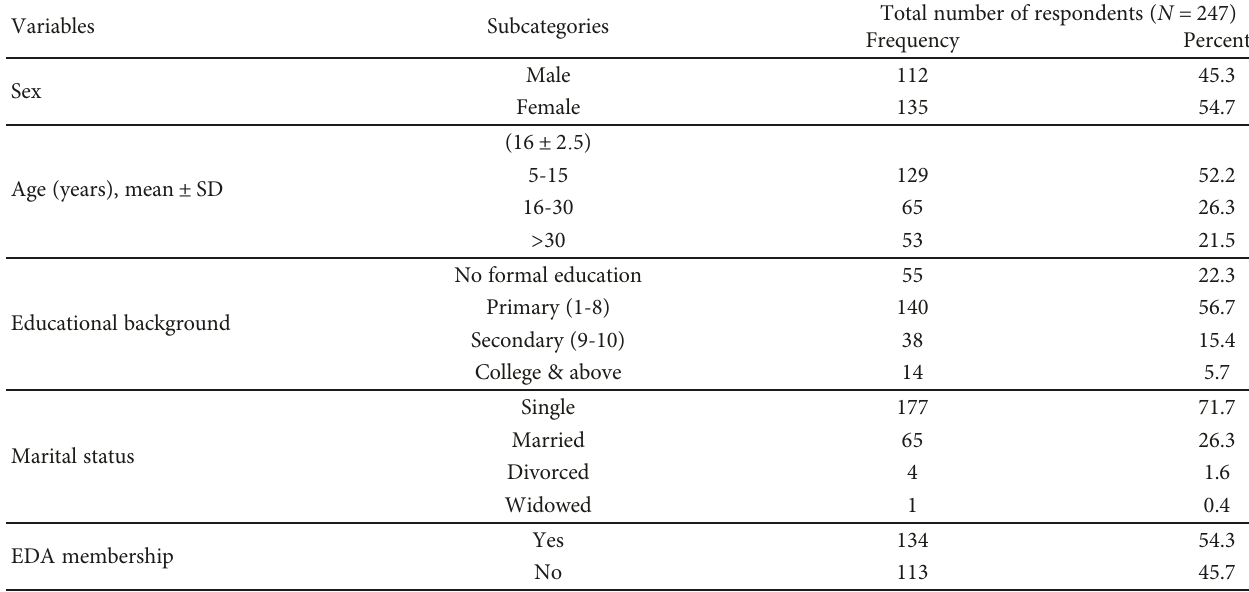
Table 1: Sociodemographic characteristics of ambulatory T1DM patients who attended the diabetes clinics of SPHMMC from June 01 to August 01,